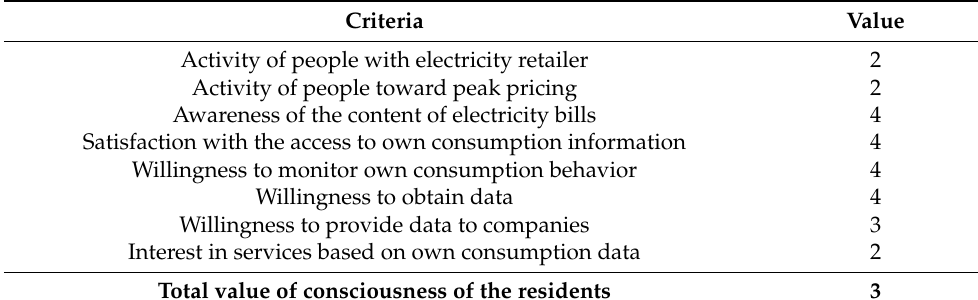
Table 6. The evaluated criteria for the consciousness of the resident. Criteria Value Activity of people with electricity retailer Awareness of the content of electricity bills Satisfaction with the access to own consumption